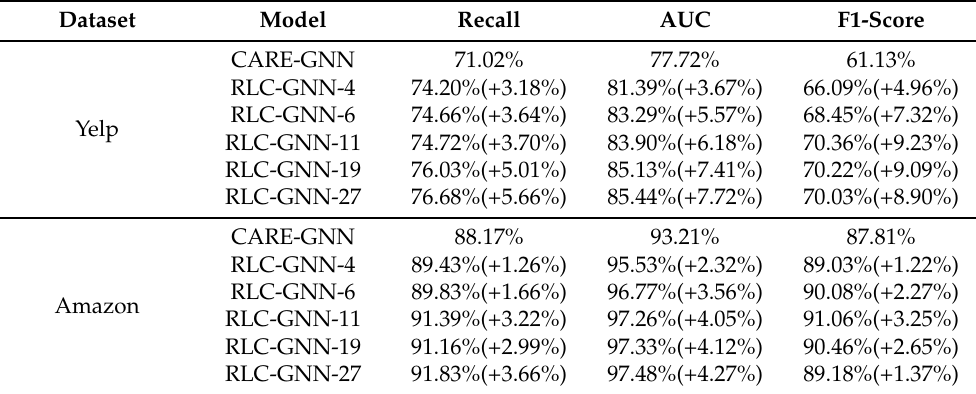
Table 3. Results of RLC-GNN with various number of layers and the baseline. We report results after running 100